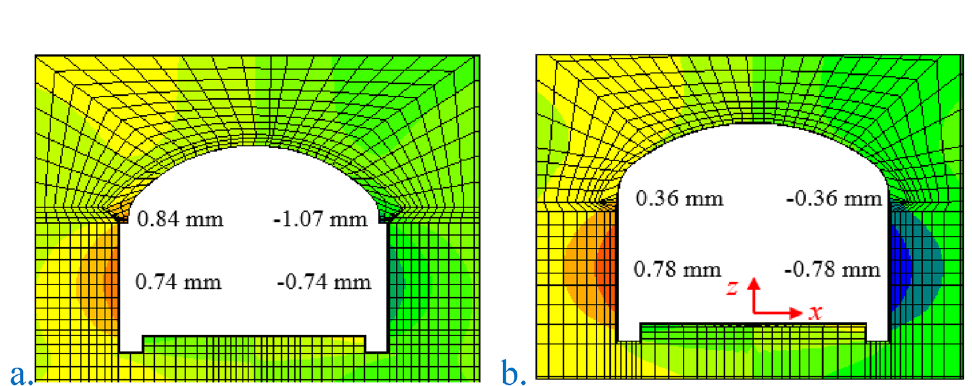
Figure 10. Horizontal displacement cloud diagram of the two construction methods. ( a ) The original scheme of the SCM (IV1); ( b ) the optimized scheme of the PCM